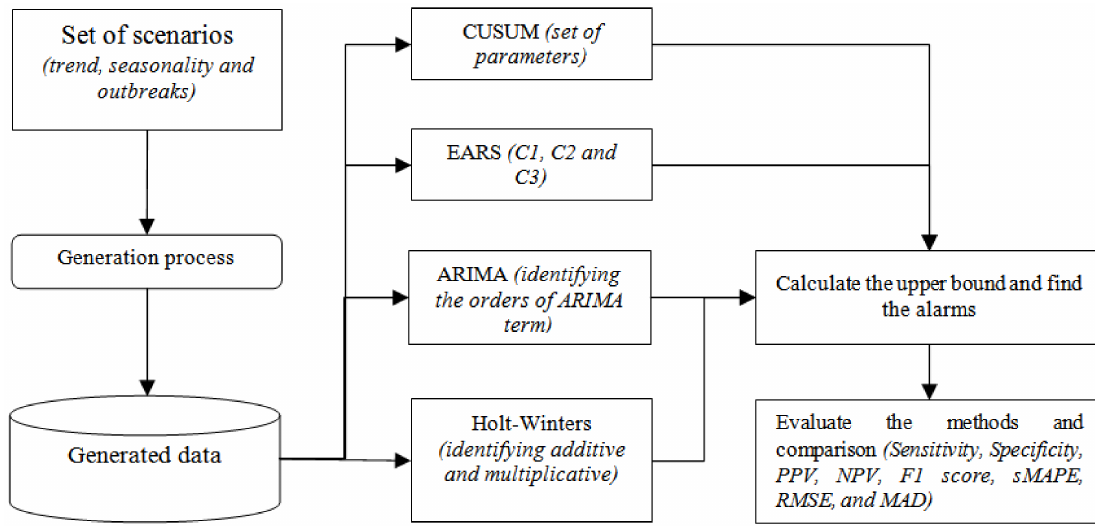
Figure 1. Framework for comparing the outbreak detection algorithms. EARS: Early Aberration Reporting System; ARIMA: auto regressive integrated moving average; PPV: positive predictive value; NPV: negative predictive value; sMAPE: symmetric mean absolute percent error; RMSE: root-mean-square error; MAD: mean absolute deviation; CUSUM: CUmulative